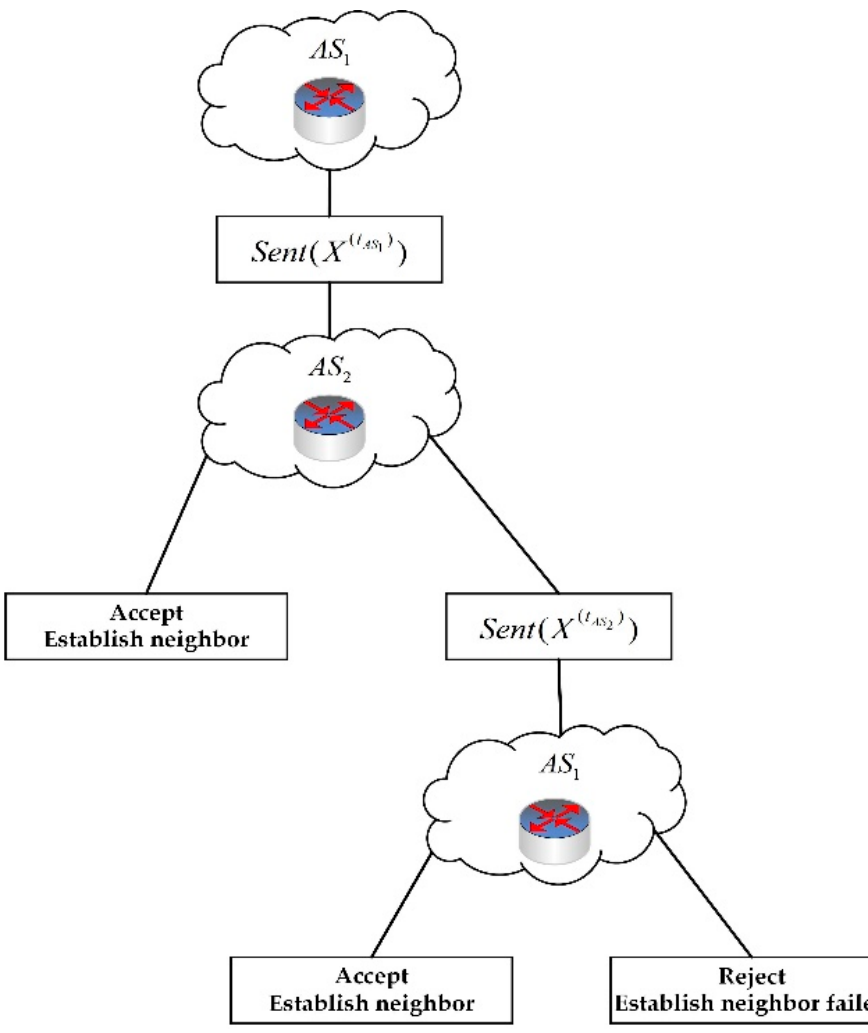
Figure 1. BNTE-BG flowchart.